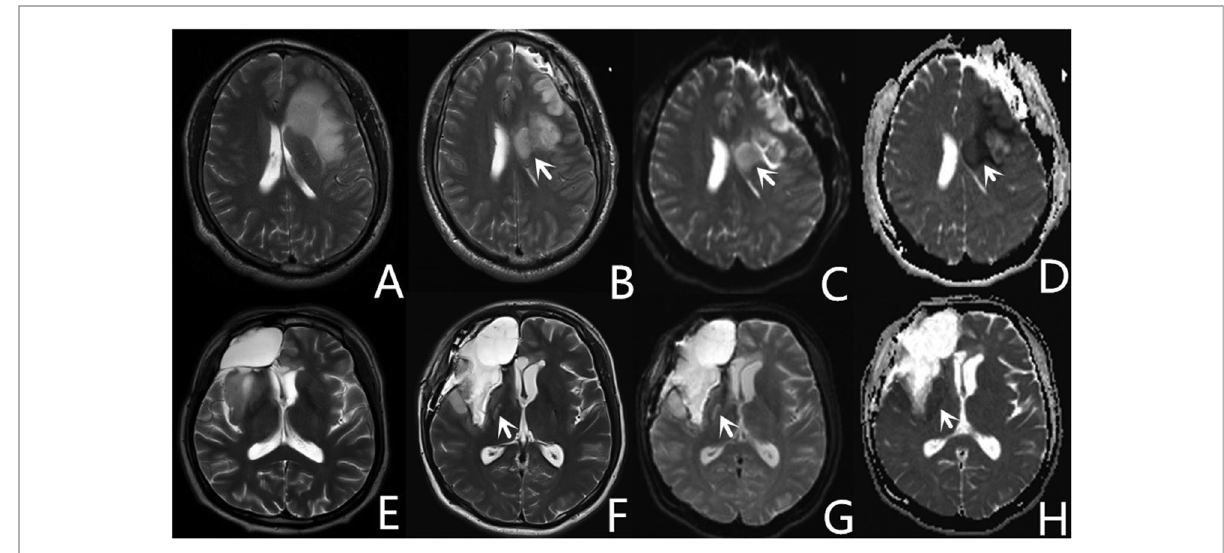
FIGURE 4 Representative images of two patients with core ischemia. One patient with postoperative ischemia (white arrow) located in the corona radiata ( A – D ), appears as hyperintense images on diffusion-weighted imaging ( C ), and hypointense images on apparent diffusion coef fi cient ( D ). Another patient with postoperative ischemia (white arrow) located in the posterior limb of the internal capsule ( E – H